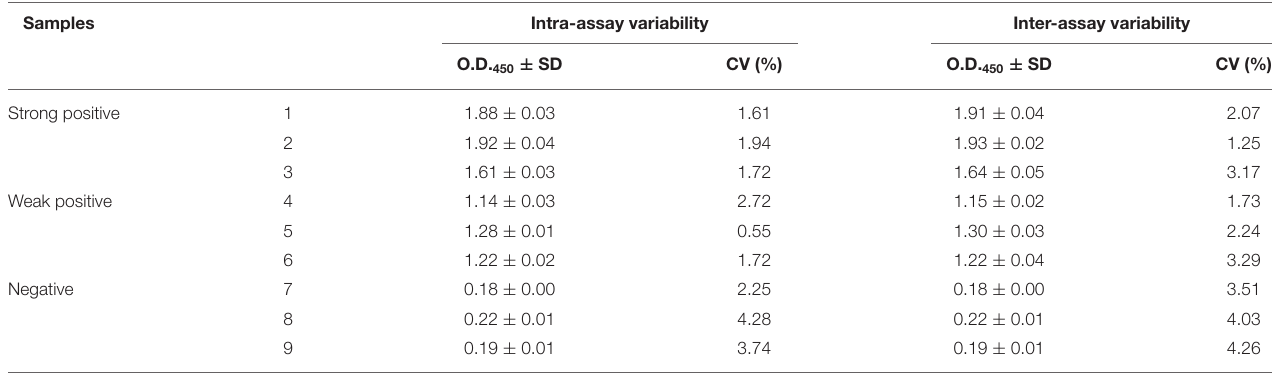
TABLE 2 | Reproducibility of the His-VP3-based ELISA in detecting IBDV-VP3 specific antibodies.